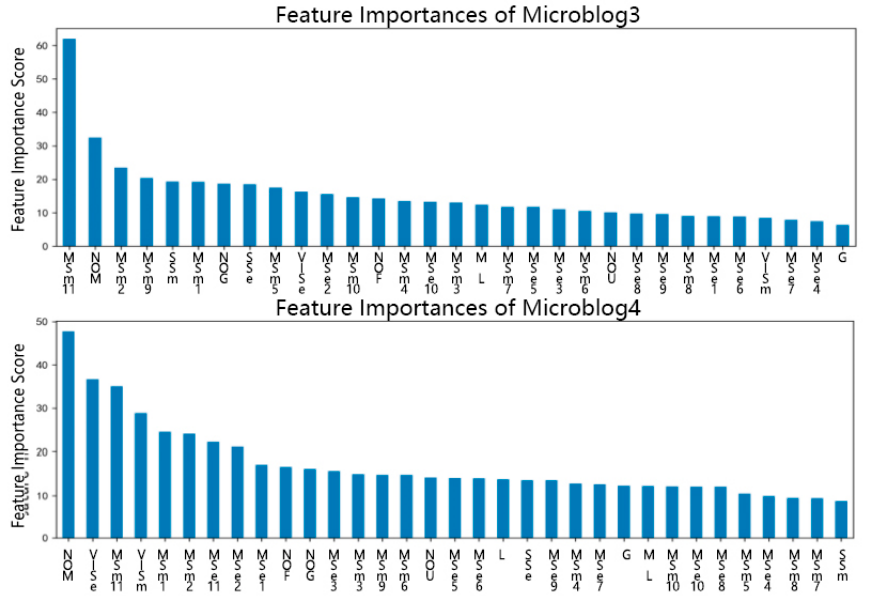
Figure 2. Feature importance bar plot based on XGBoost.